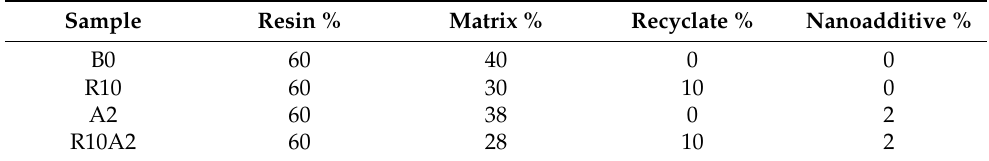
Table 1. Percentage (by weight) of individual components.